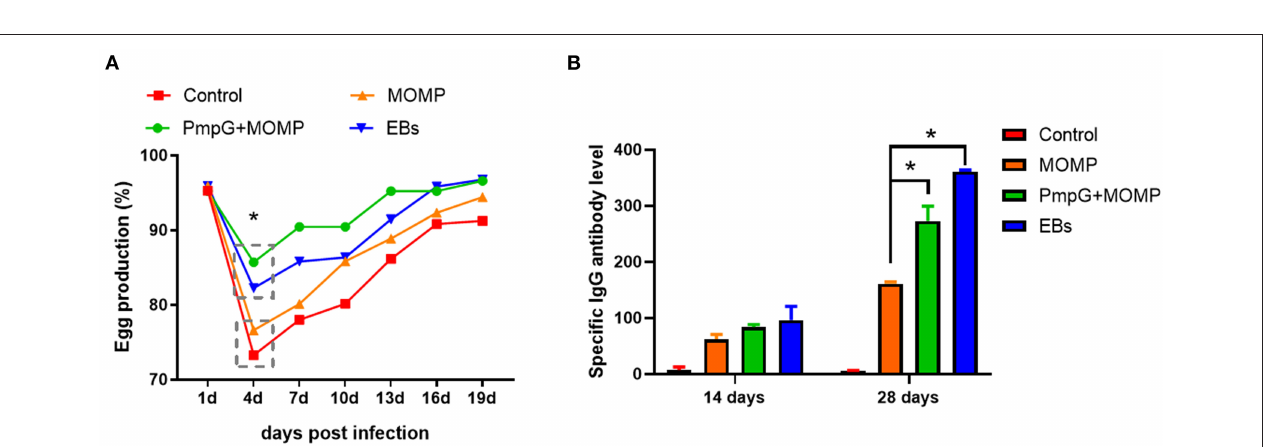
FIGURE 5 | Chlamydial loads and shedding of SPF chickens post Chlamydial challenge. (A) Lower shedding was determined in the PmpGs + MOMP group than the other three groups did ( p < 0.05). (B) Bacterial clearances in the lungs were reduced significantly in the PmpGs + MOMP group compared with those of the PmpGs group alone and the MOMP group ( p < 0.05). The differences were analyzed by ANOVA (* p < 0.05).